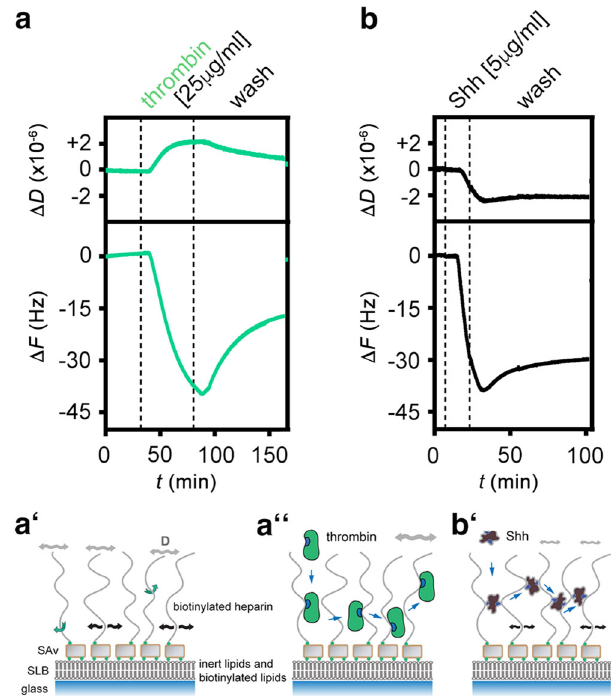
Fig. 5 | QCM-D analysis of Shh interactions with heparin. a – a ″ Schematic representation and real-time analysis of thrombin binding to the functionalized QCM-D sensor surface. a ′ represents the HS/heparin model matrix assembled on a silica surface. The supported lipid bilayer (SLB) exposes 5% biotinylated lipids that bindtostreptavidin(SAv)linkedtobiotinylatedheparin.Greenarrowsindicatefree rotation of the coupled heparin chain, black arrows lateral movement on the SLB, and gray double-headed arrows indicate softness of the matrix (as sensed by increased dissipation, Δ D ). a Thrombin binding decreases Δ F during the protein incubationstepand increases Δ D correspondingly,demonstrating proteinbinding and retention of a relatively soft heparin/thrombin layer ( a ″ ). b , b ′ Similar protein loading of the functionalized matrix (- Δ F about − 40 Hz in both cases) by Shh is achieved more quickly(as indicatedby faster Δ F decrease) and isassociated with a negative Δ D ,indicatingthatShhrigidi fi estheheparinlayer.The fi lmrigidi fi cationis due to heparin cross-linking (as con fi rmed by complementary FRAP assays, see Supplementary Fig. 6c). Representative graphs of three independent experiments are shown.